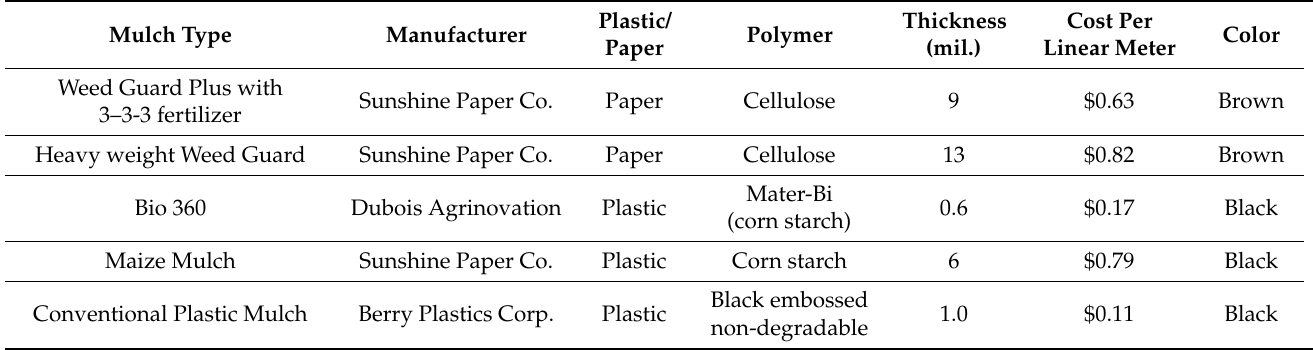
Table 1. Mulch brands trials in the 2020 Louisiana/Mississippi biodegradable mulch experiment. Mulch